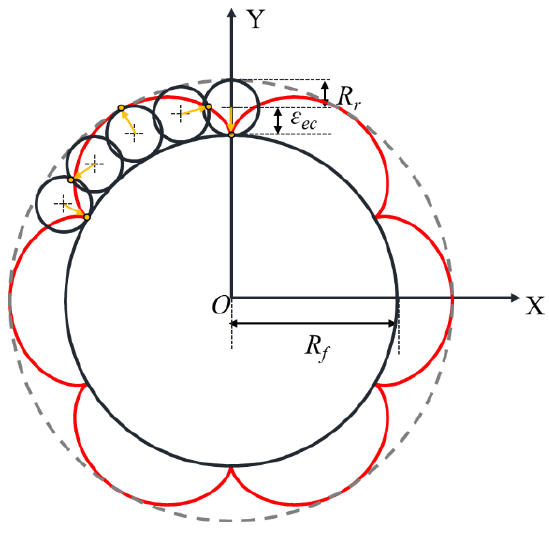
Figure 1. Epicycloid curve.